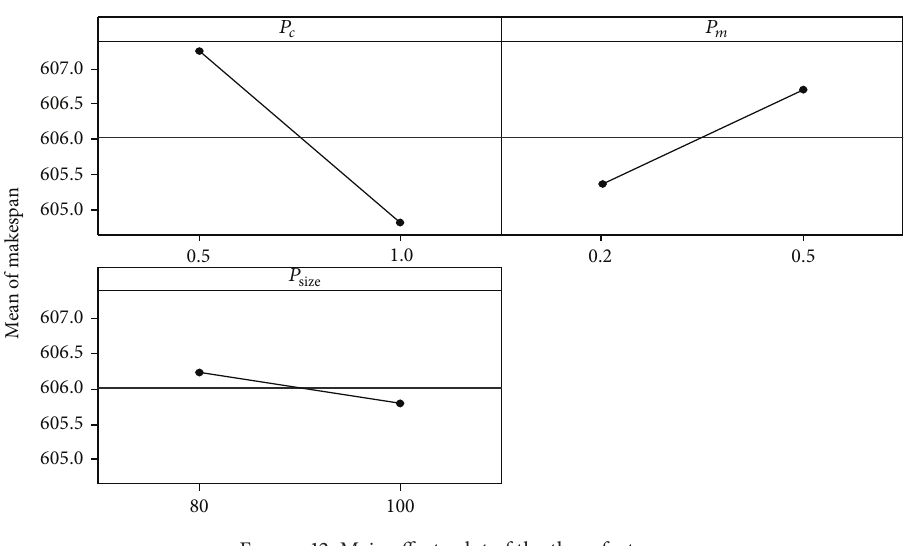
Figure 12: Main effects plot of the three factors. Table 8: The comparison of solution